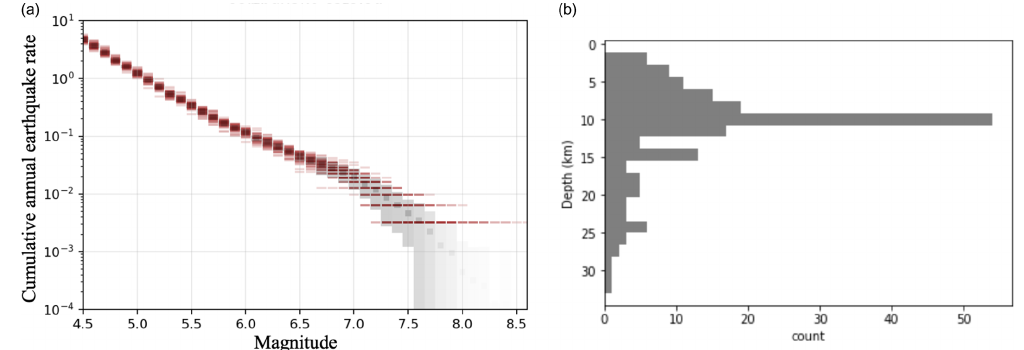
Figure 3. (a) Magnitude frequency distribution for the study area calculated from the catalogue and the completeness periods presented in Table 2. The red dashes are individual Monte Carlo samples of the earthquake magnitude uncertainties and the completeness period. The mean rate value is indicated by grey squares, and the 16th and 84th percentiles are indicated by the grey area. (b) Depth distribution of earthquakes of magnitude 4.5 and above in the background zone (Kadirio˘glu et al., 2018) since 1992. Table 3. Annual rate of M 7 . 2 + earthquakes on sections of the NAF deduced from palaeoseismic studies. Site Reference Number of Observation Annual earthquake Uncertainty events time (years) rate Ganos 1 Rockwell et al.